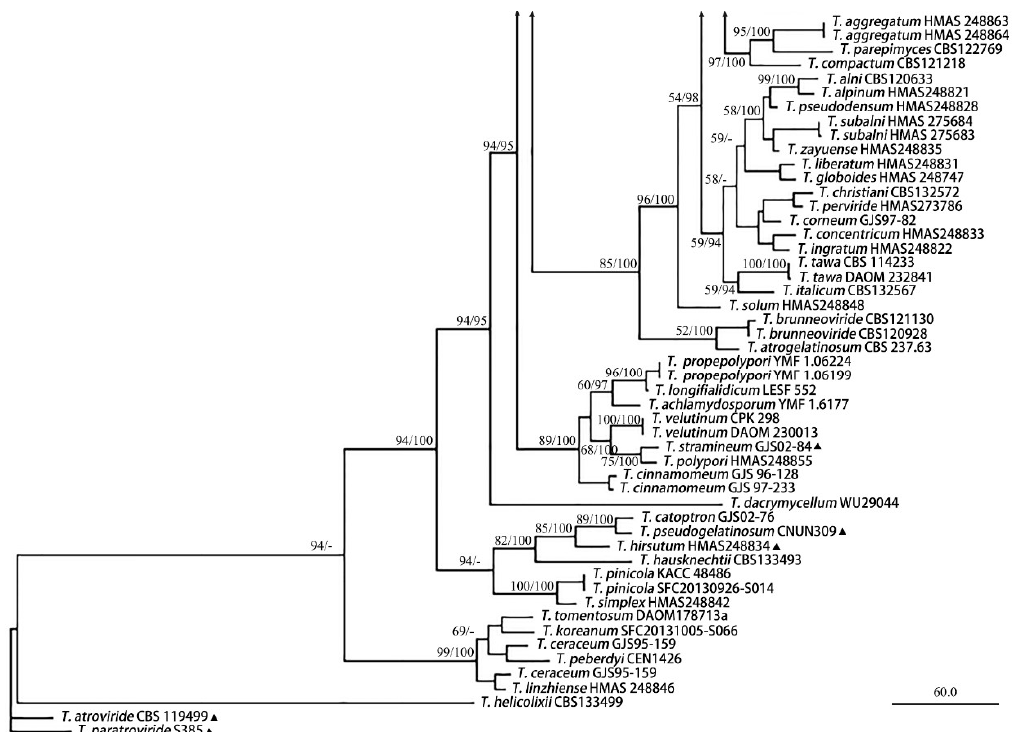
Figure 1. Maximum parsimony phylogram of the investigated Trichoderma species inferred from the combined sequences of rpb2 and tef1- α . MPBP above 50% (left) and BIPP above 90% (right) are indicated at the nodes. New species proposed are indicated in red font. Trichoderma species isolated from substrate or fruiting bodies of edible fungi are marked with ▲ .